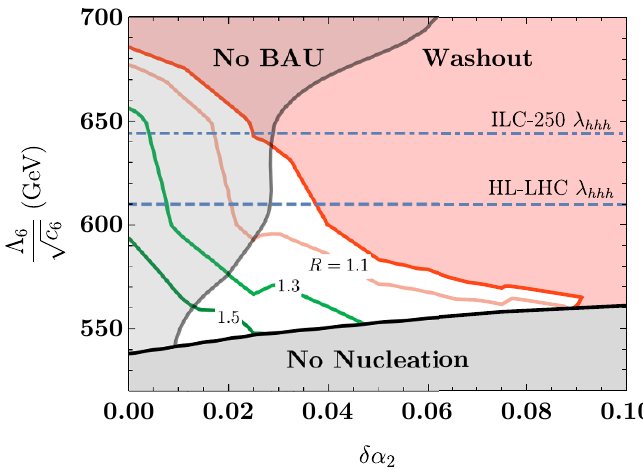
p Figure 3 . Viable parameter space as a function of (cid:14)(cid:11) 2 and (cid:3) 6 = c 6 , for (cid:14)(cid:11) 3 = 0. The grey p region at lower values of (cid:3) 6 = c 6 is ruled out due to bubbles of true vacuum not being able to nucleate. The transparent grey region on the left shows where an insu(cid:14)cient BAU is produced p given (cid:3) CPV = (cid:14) CPV = 7 : 3 TeV. The red region is where su(cid:14)cient BAU is produced outside of the true vacuum, but the phase transition is too weakly (cid:12)rst order and hence the EW sphalerons wash out the BAU in the broken phase. The red, pink, light green and dark green contours correspond to values of the ratio R , de(cid:12)ned in eq. (4.14), of 1, 1 : 1, 1 : 3 and 1 : 5 respectively. Also shown are contours corresponding to the 68% CL bounds from HL-LHC (dashed) and ILC-250 (dot-dashed), as found in [61].